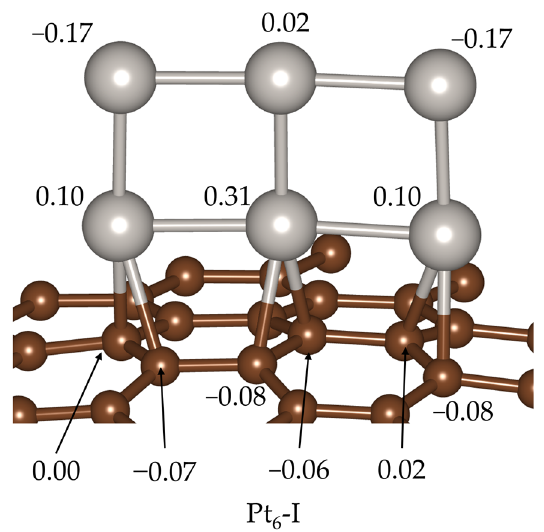
Figure 3. Bader charges in (in au) for relevant atoms of the GM (Pt 6 -I). Positive charges are depicted in.